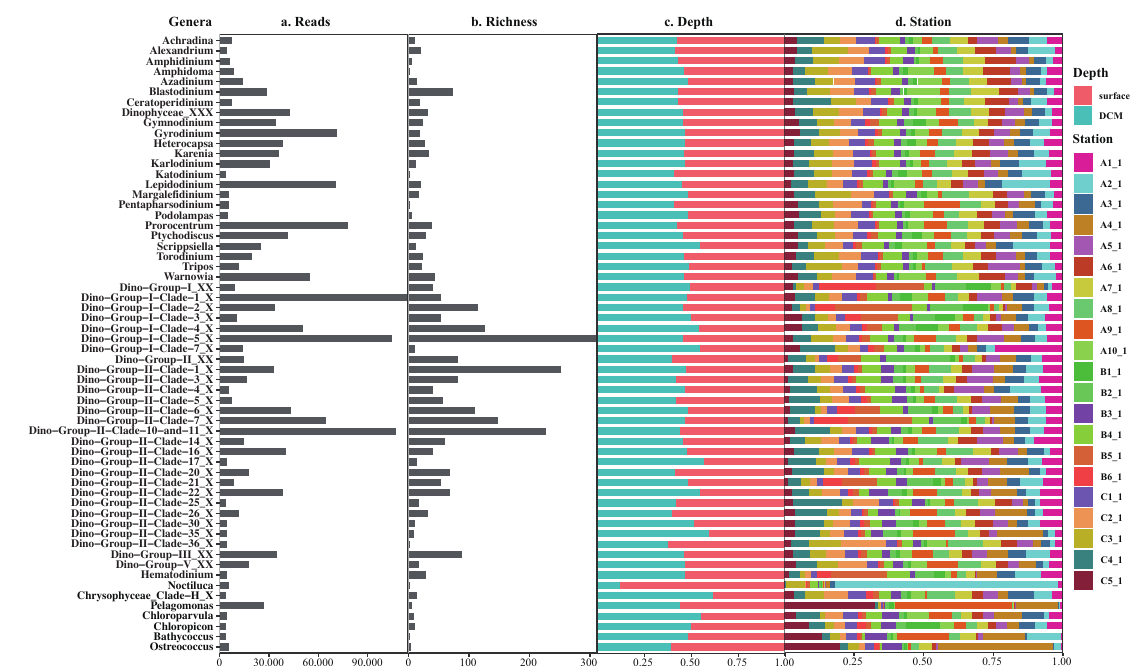
Figure 6. The composition and distribution of top 60 genera in the Western Pacific seamount